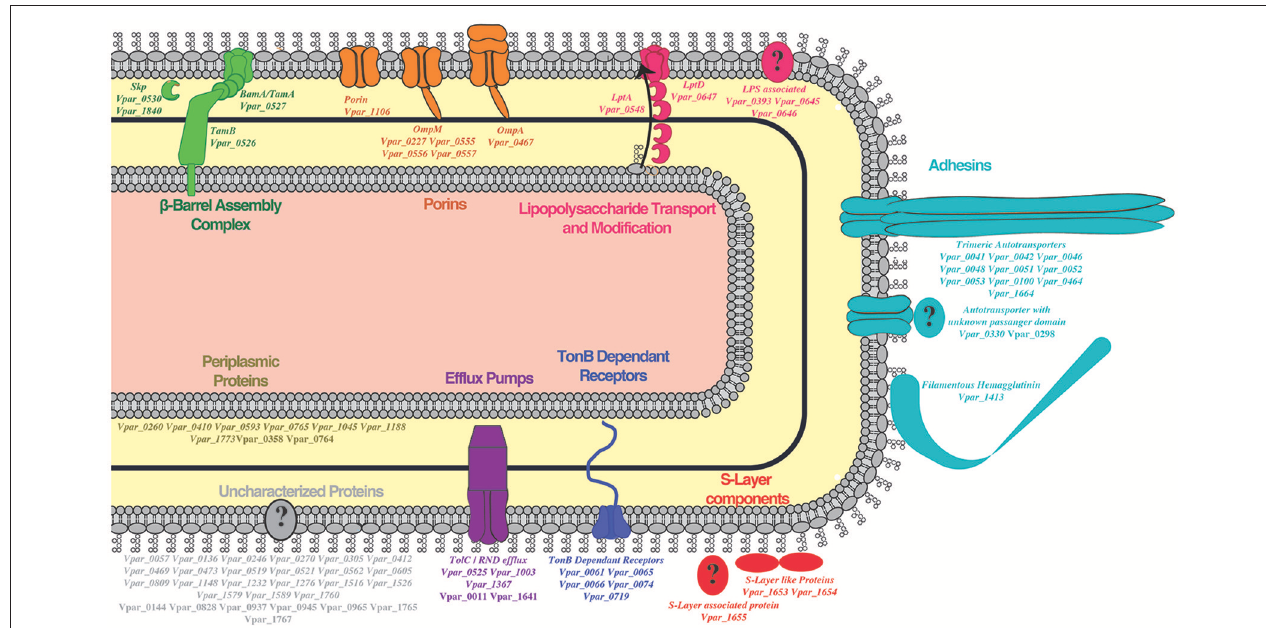
FIGURE 3 | Outer membrane proteome schematic demonstrating the different systems detected by our methods. Proteins found in the OM are in bold while SE detection is indicated by bold and